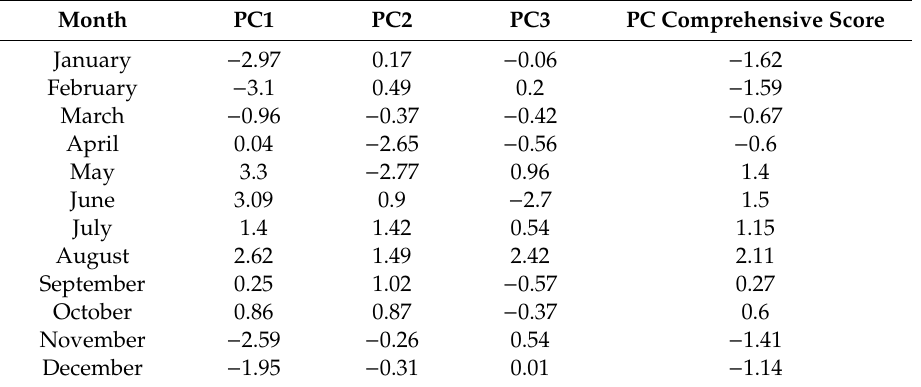
Table 2. Component score of di ff erent